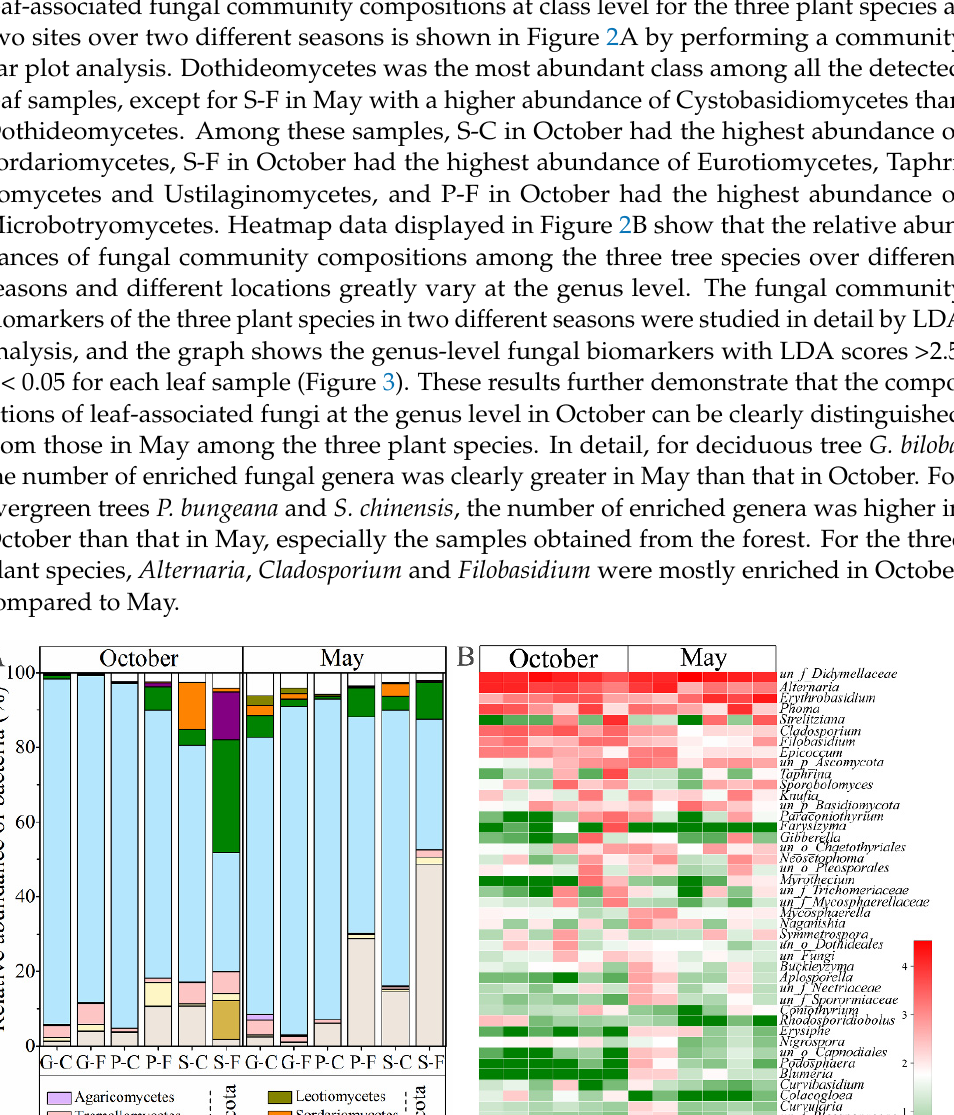
Figure 3. Taxonomic differences at genus level among phyllospheric fungi in October and May of three types of trees in campus ( A ) and forest ( B ) by a linear discriminant analysis (LDA). G-C-Octo- ber, G. biloba from campus obtained in October; G-C-May, G. biloba from campus obtained in May; P-C-October, P. bungeana from campus obtained in October; P-C-May, P. bungeana from campus obtained in May; S-C-October, S. chinensis from campus obtained in October; S-C-May, S. chinensis from campus obtained in May; G-F-October, G. biloba from forest obtained in October; G-F-May, G. biloba from forest obtained in May; P-F-October, P. bungeana from forest obtained in October; P-F- May, P. bungeana from forest obtained in May; S-F-October, S. chinensis from forest obtained in Oc- tober; S-F-May, S. chinensis from forest obtained in May.